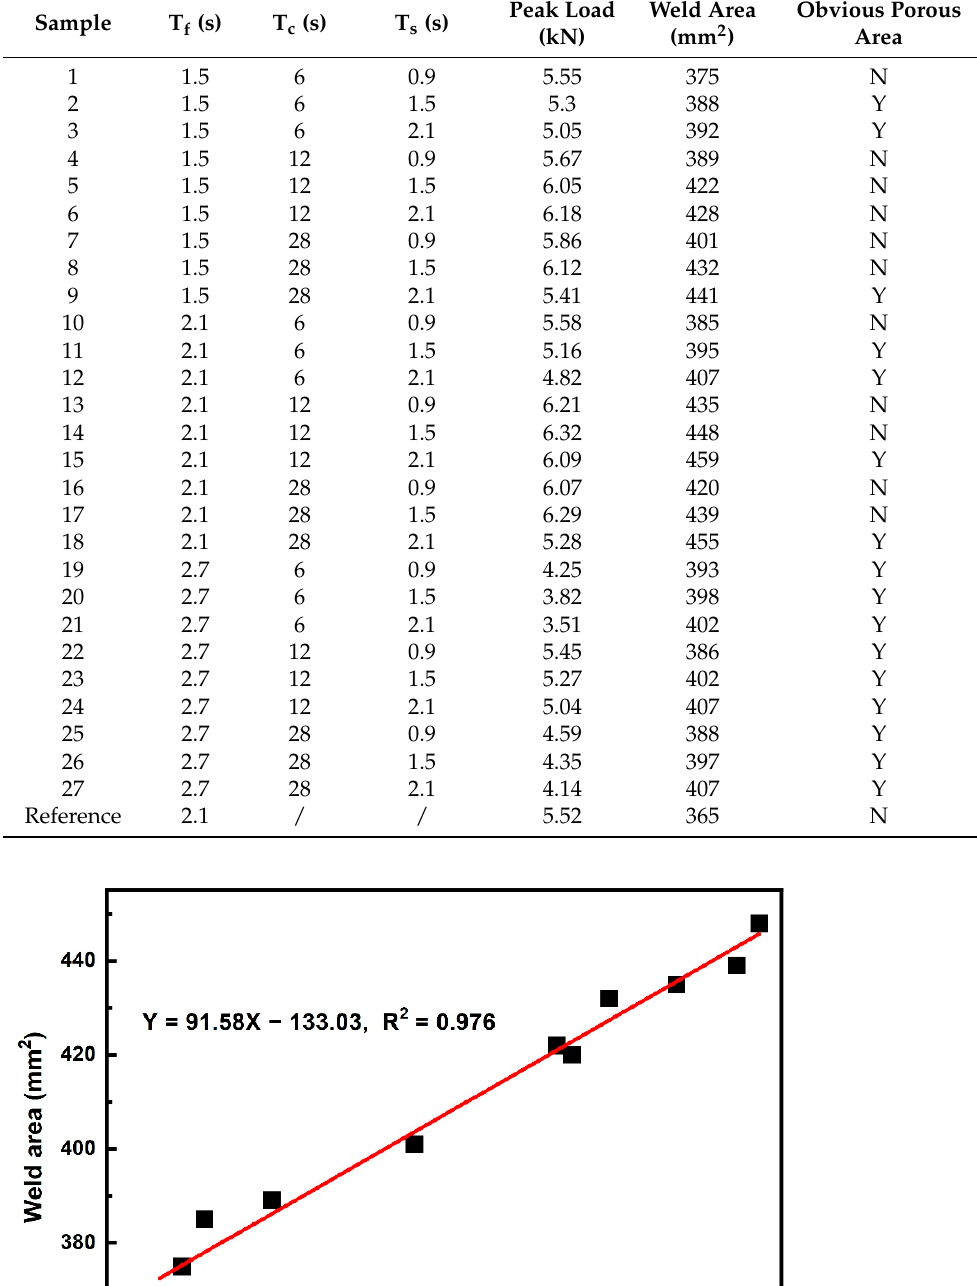
Table 2. Test data for DPUWed CF/PA66 composite.